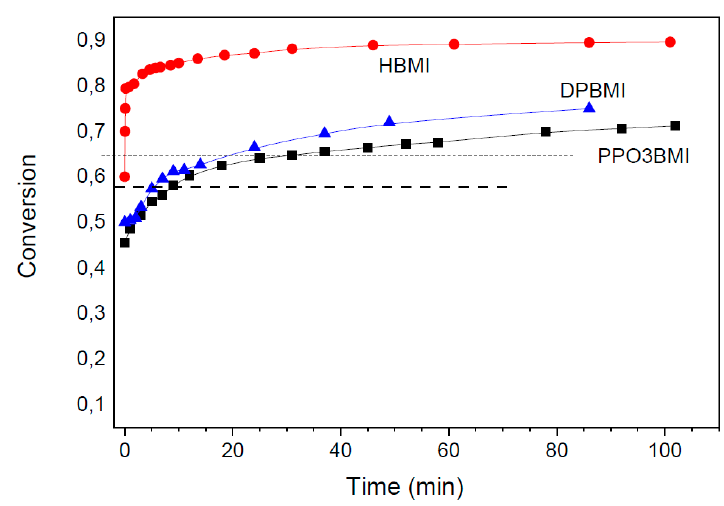
Figure 2. Conversion of the maleimides as a function of time during the reaction with F4D2000 in the partially split up structure. T = 50 °C. Dashed lines: theoretical critical conversions for gelation of the ideal system and including cyclization.